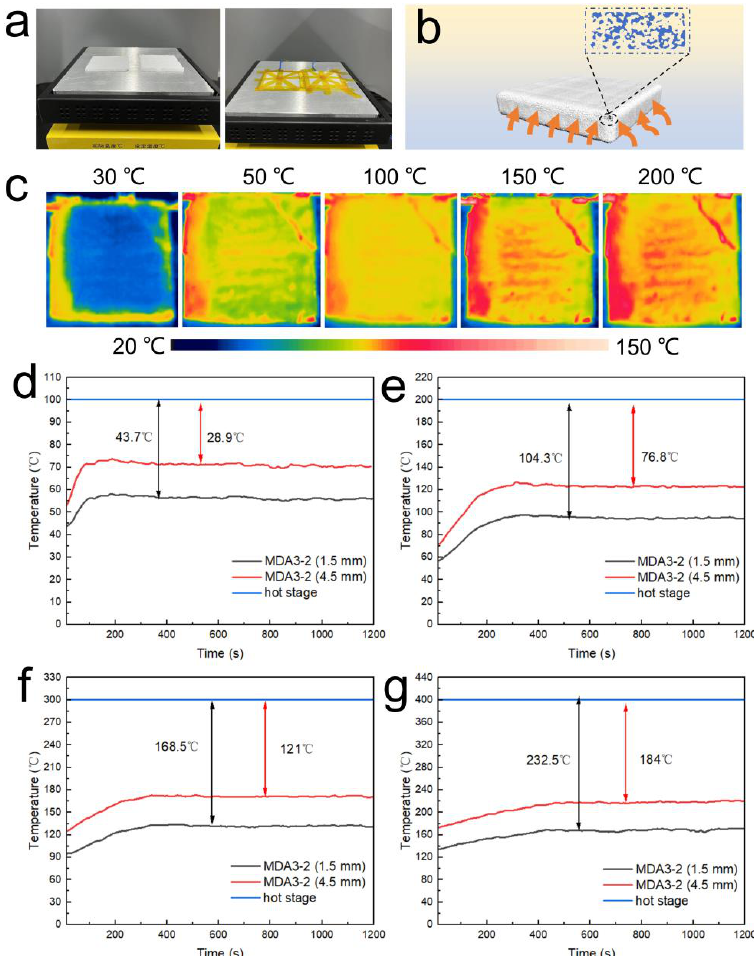
Figure 3. ( a ) Photo images of the MDAs presented on a hot stage; ( b ) carton image illustrating the thermal insulation performance of MDA; ( c ) IR images of the MDAs presented on the hot stage; ( d ) the temperature changes of the upper side of the MDA on a hot stage of 100 ◦ C; ( e ) the temperature changes of the upper side of the MDA on a hot stage of 200 ◦ C; ( f ) the temperature changes of the upper side of the MDA on a hot stage of 300 ◦ C; ( g ) the temperature changes of the upper side of the MDA on a hot stage of 400 ◦